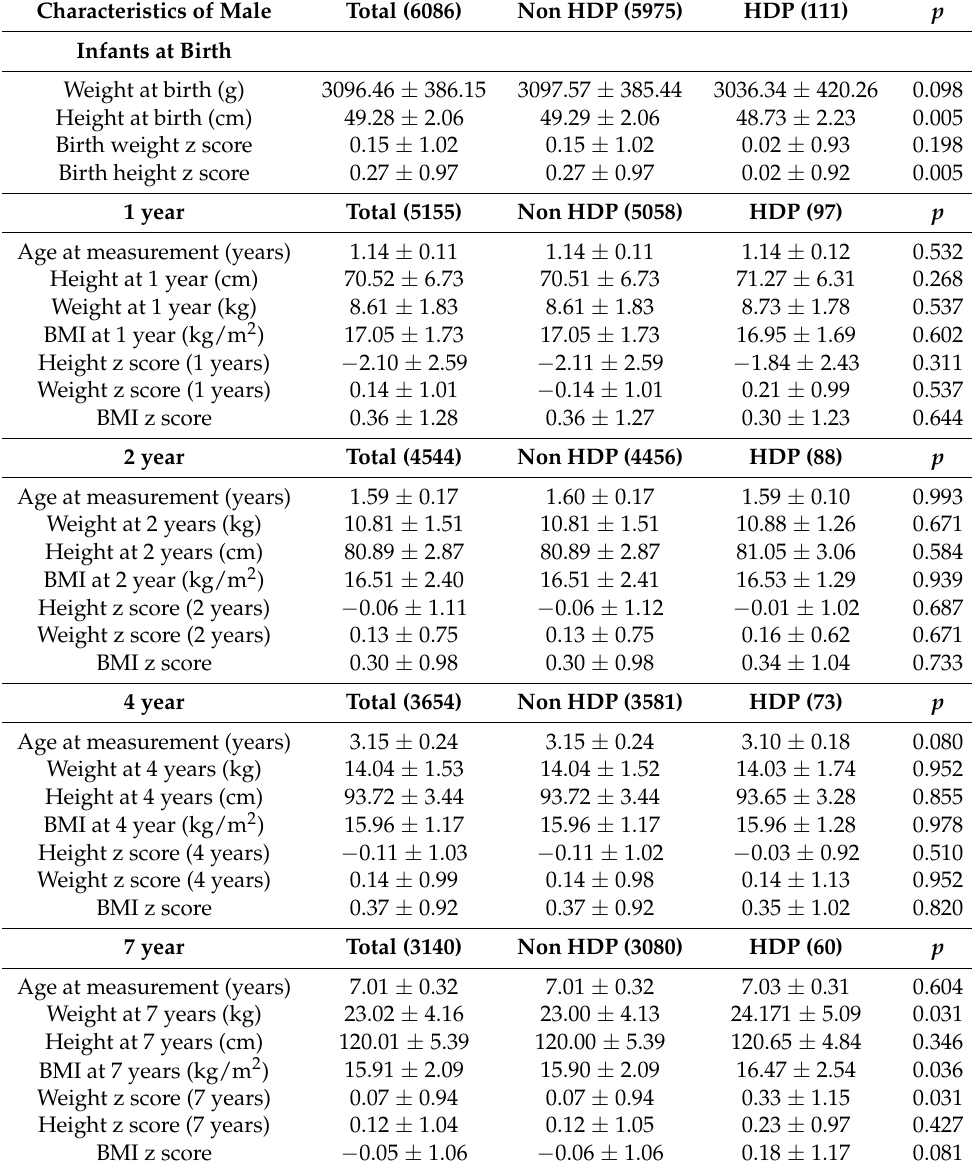
Table 2. Demographic information of male children from birth to seven